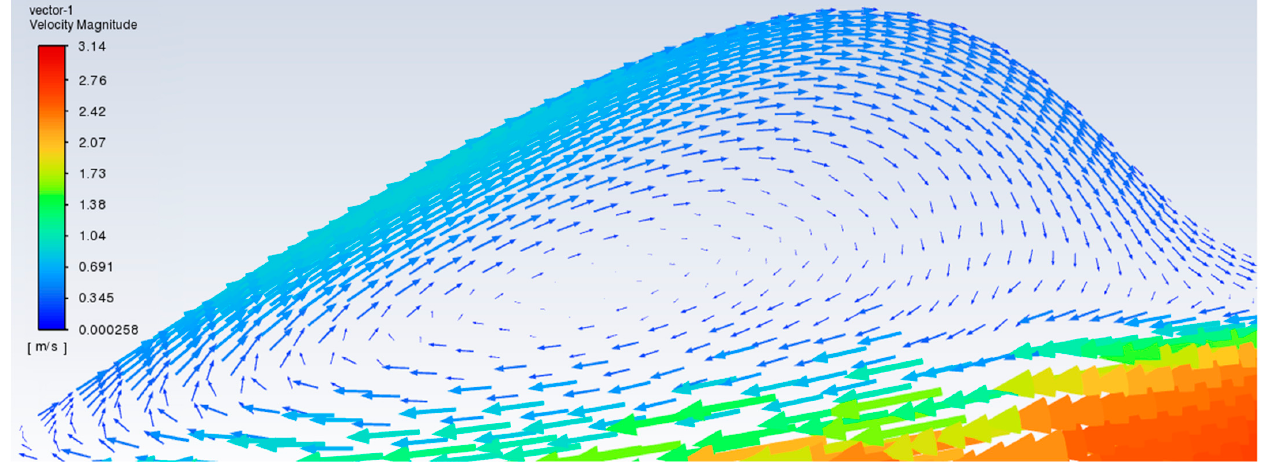
Figure 15. Flow Field Around Neck Region of Female Body from Side View.